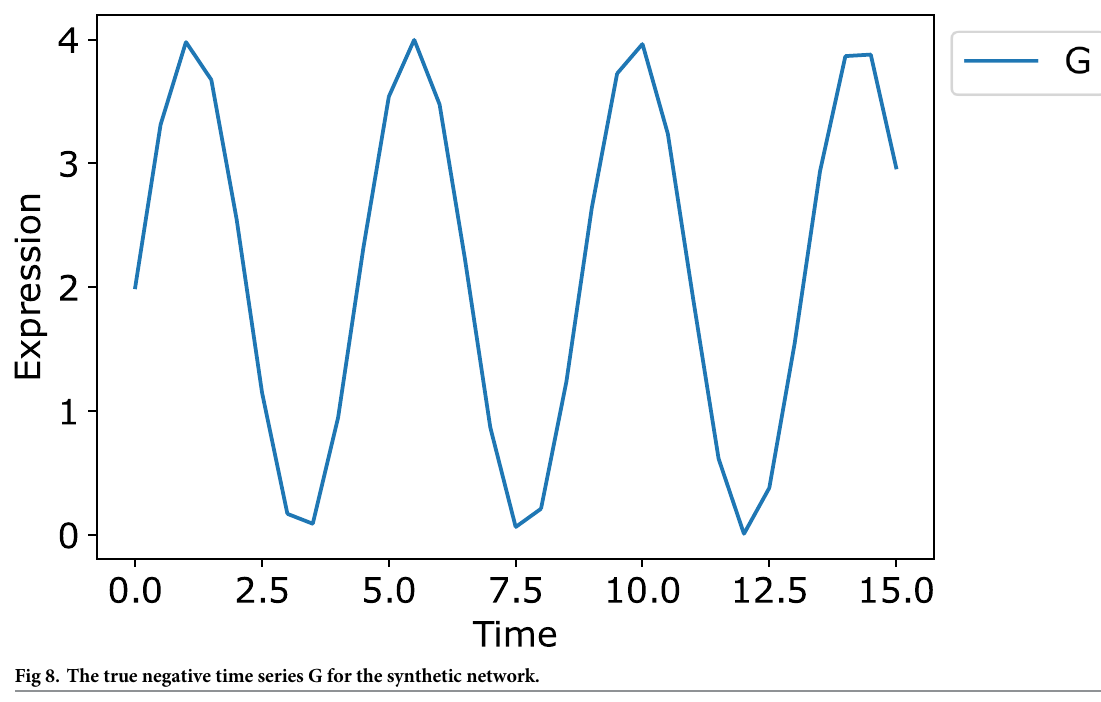
Fig 8. The true negative time series G for the synthetic